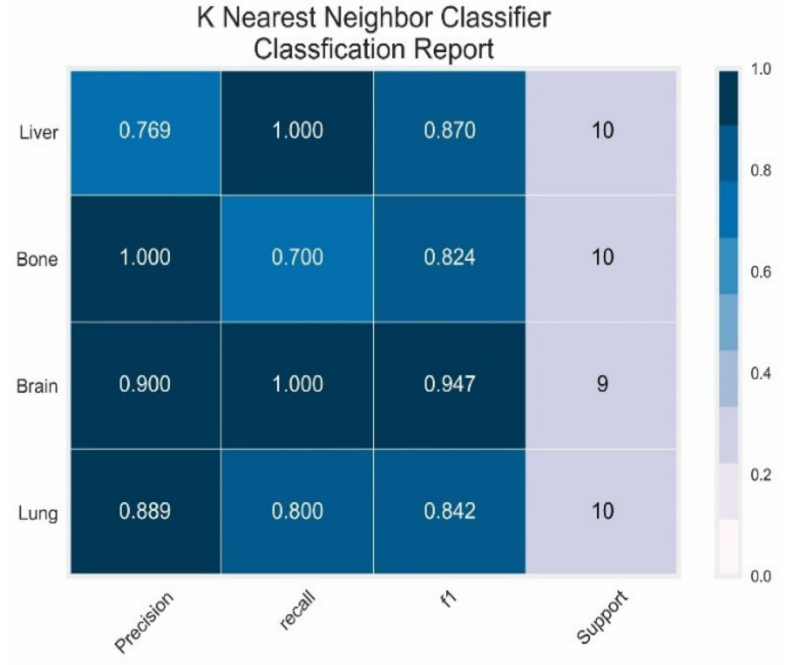
Figure 22. Classification Report (K-Nearest Neighbor